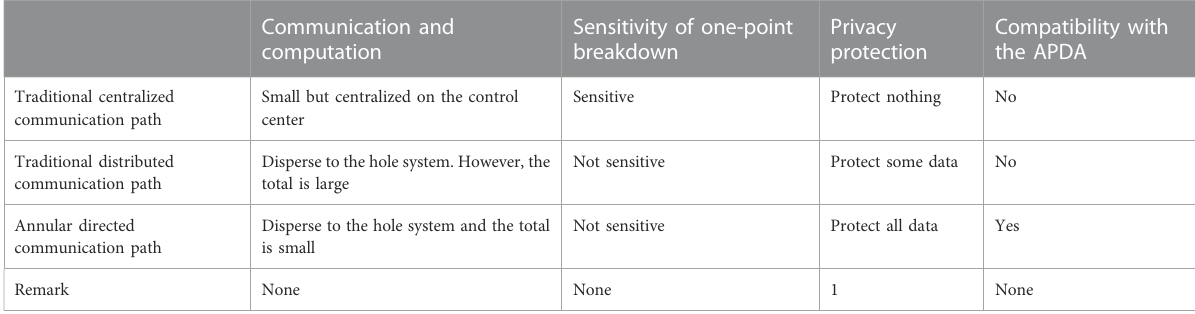
TABLE 4 Devices in each